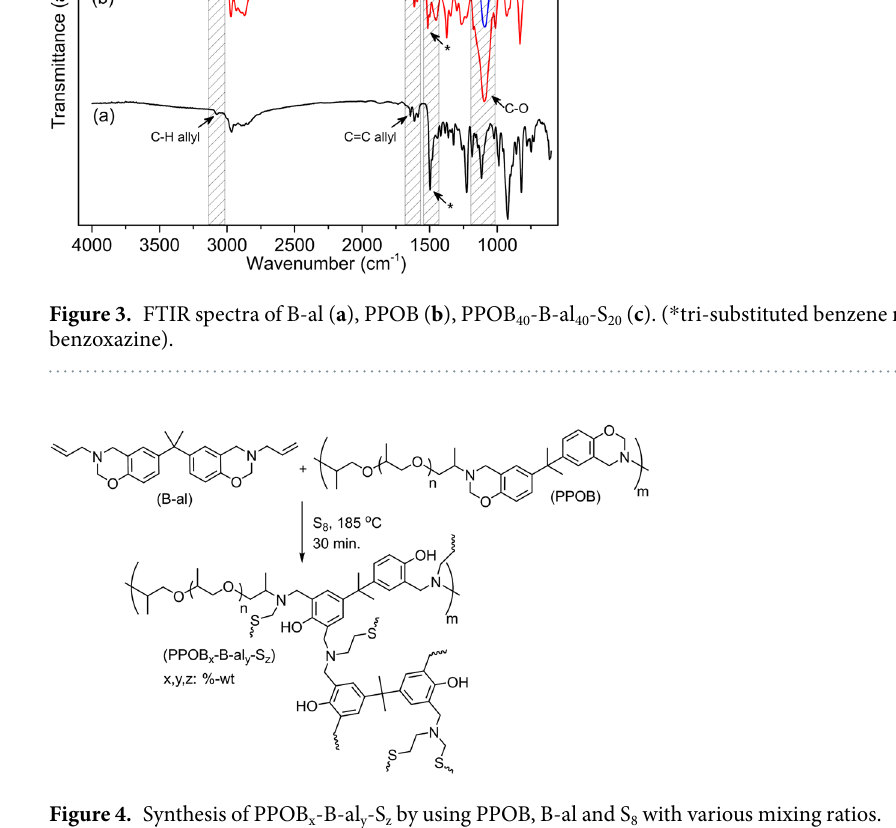
Figure 4. Synthesis of PPOB x -B-al y -S z by using PPOB, B-al and S 8 with various mixing